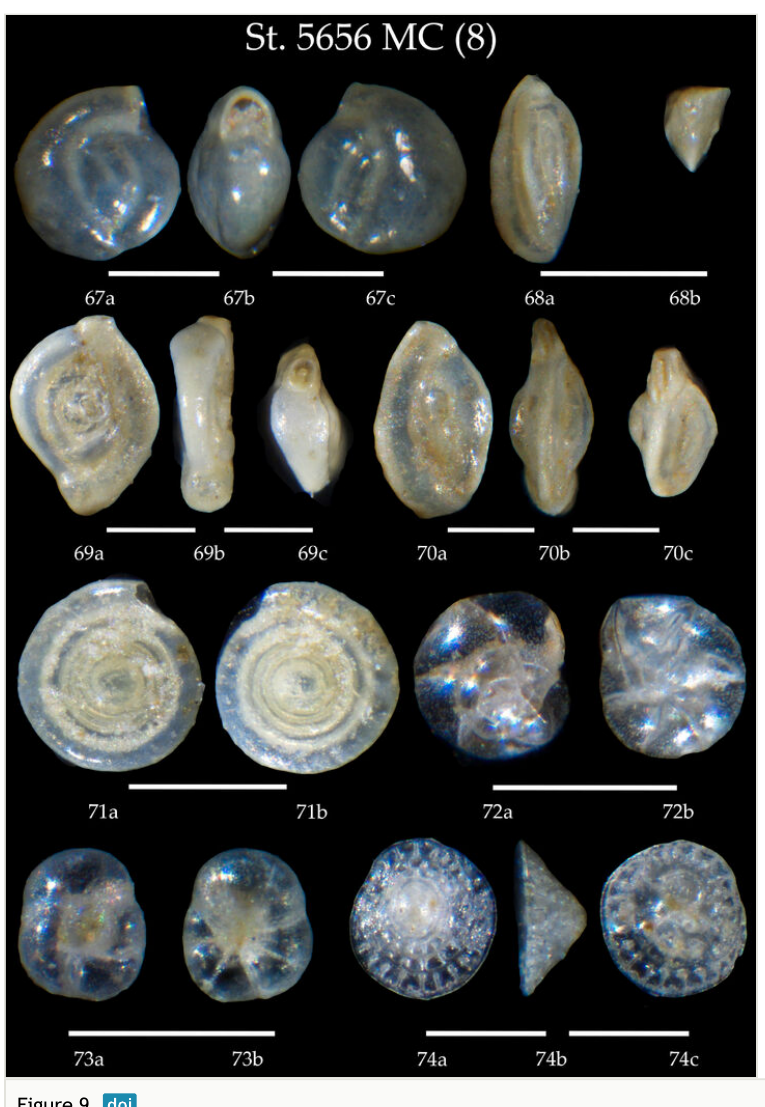
Figure 9. Station 5656 MC (continued). 67 Miliolinella subrotunda , a side view, b apertural view, c lateral view; 68 Triloculina elongata , a side view, b apertural view; 69 Spiroloculina excavata , a, b side view, c apertural view; 70 Massilina secans , a, b side view, c apertural view; 71 Cornuspira involvens , a side view, b lateral view; 72 Epistominella exigua , a spiral view, b umbilical view; 73 Glabratella altispira , a spiral view, b umbilical view; 74 Patellina corrugate , a spiral view, b apertural view, c umbilical view. Scale 100